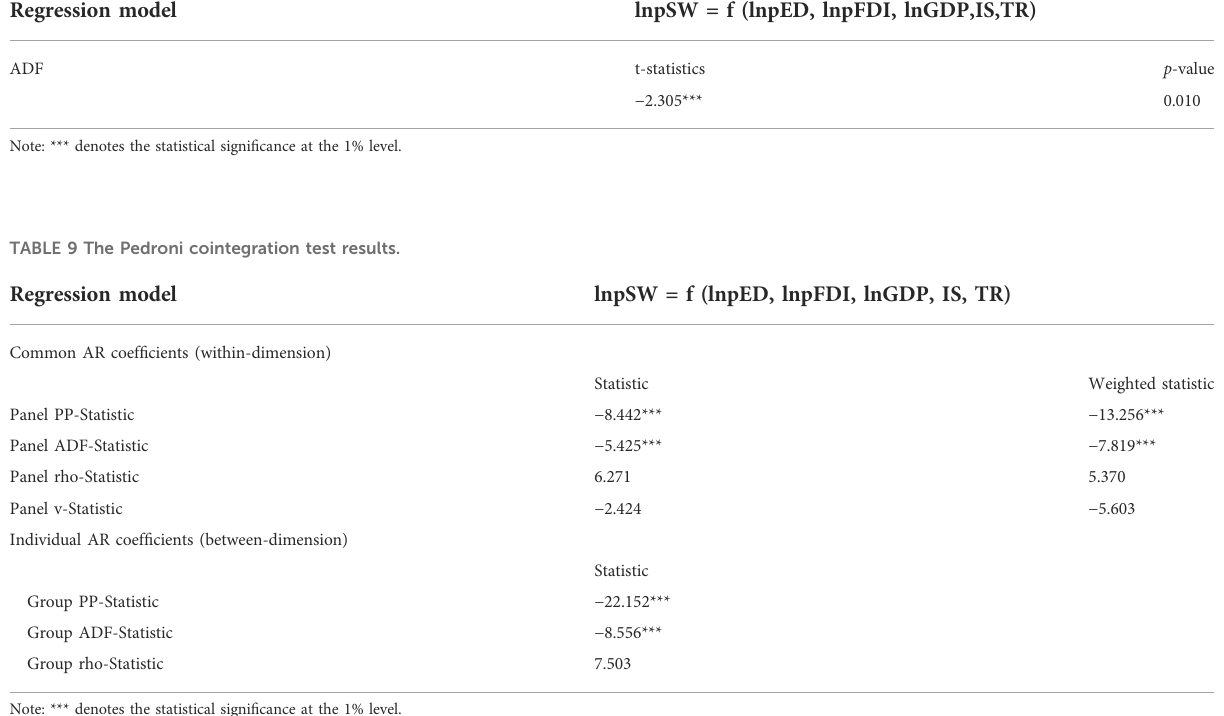
TABLE 8 The Kao panel cointegration test results.